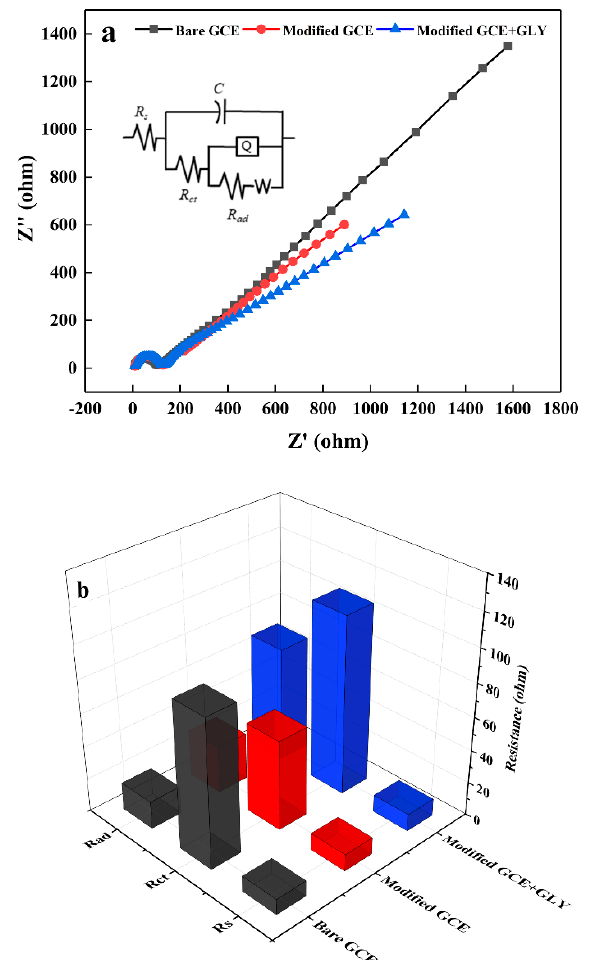
Figure 4. ( a ) Electrochemical impedance spectroscopy (EIS) of the different electrodes in 0.1 M KCl solution (the equivalent circuit was in the inset) and ( b ) the fitting resistance value of the equivalent circuit.